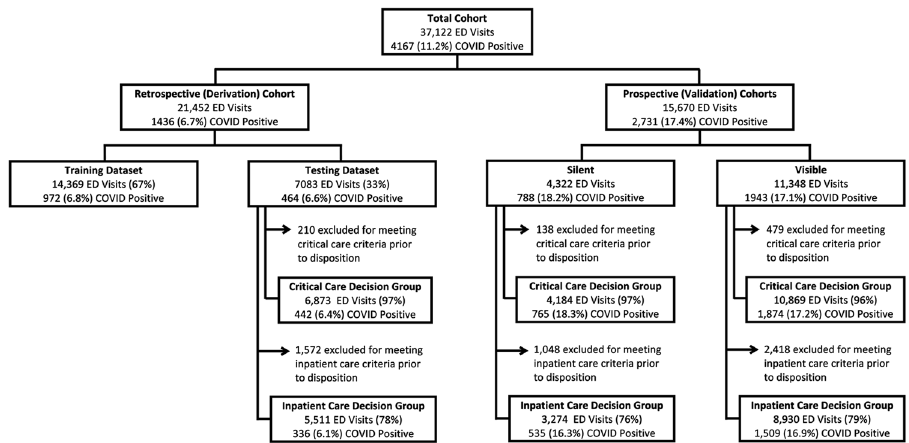
Fig. 1 Study inclusion fl